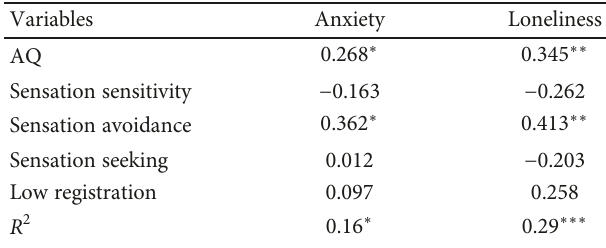
Table 3: Multiple regressions of autism spectrum traits and sensory processing on anxiety and loneliness (standardized coe ffi